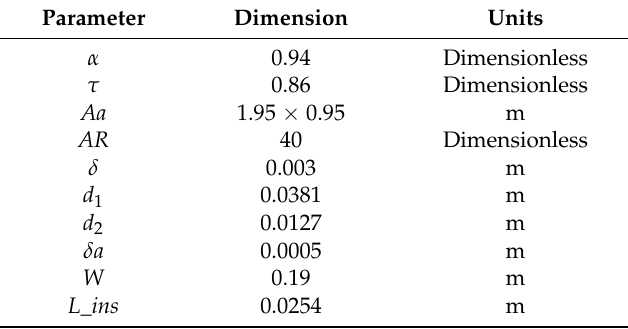
Table 1. Manufacture characteristics of the solar collector.